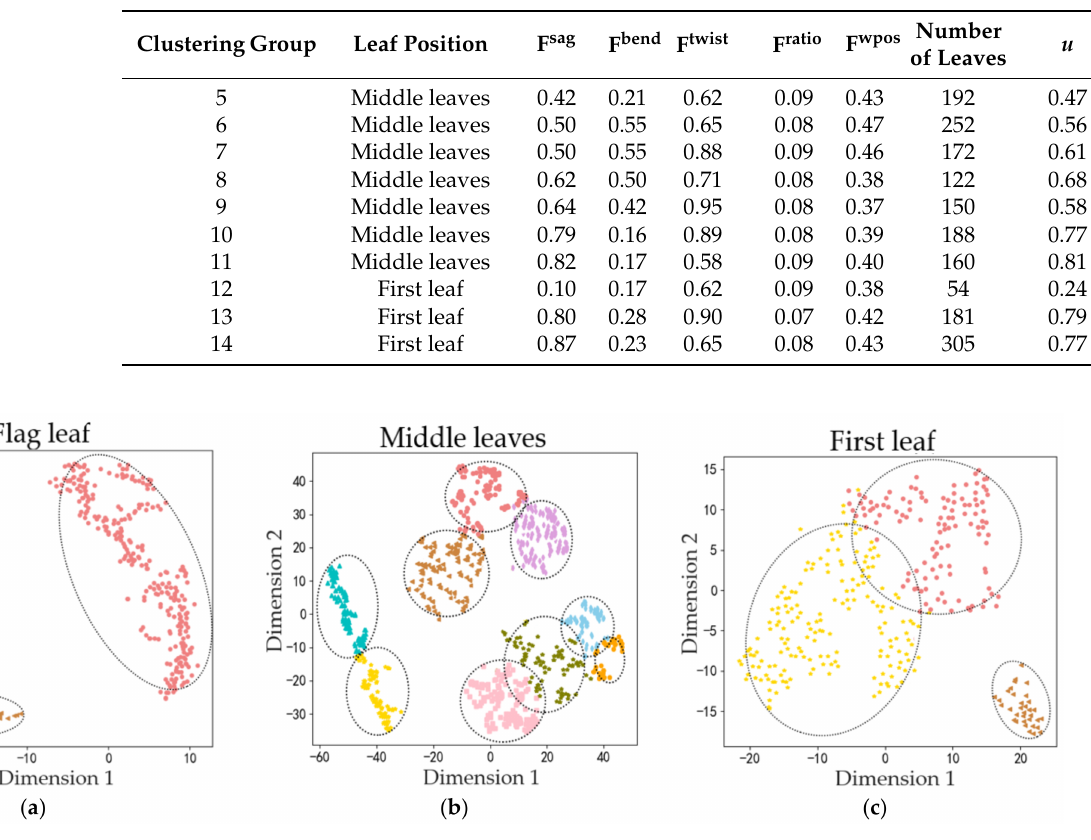
Figure 3. Leaf clustering results based on five morphological leaf parameters. ( a )–( c ) are the clustering results of flag leaf, middle leaves, and first leaf, respectively. Dimension 1 and Dimension 2 are the two principal components in PCA and each circle is a cluster category. Different colors are used to distinguish the